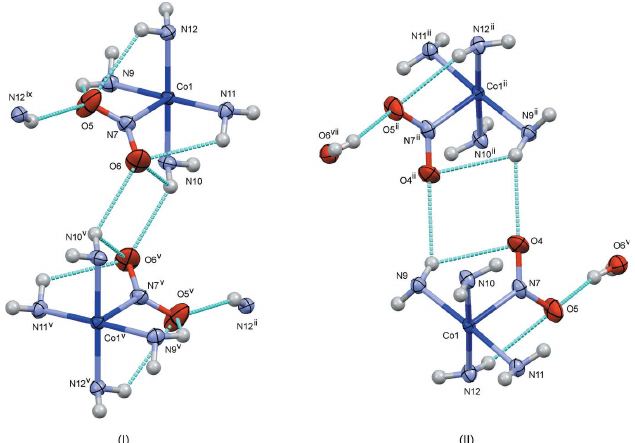
Figure 11 Comparison of the short contact pair of the nitro group in (I) and (II). Dashed lines in blue show the O(nitro) (cid:2)(cid:2)(cid:2) H short contacts shorter than 2.5 A˚ . Only parts of the diamine ligands are shown for clarity. Symmetry codes for (I): (ii) (cid:3) x + 1 , y (cid:3) 1 , (cid:3) z + 1 ; (v) (cid:3) x + 1 , (cid:3) y + 1 , (cid:3) z ; (ix) x , (cid:3) y , 2 2 2 2 2 z (cid:3) 1 , . For (II): (ii) (cid:3) x + 1, (cid:3) y + 1, (cid:3) z + 1, (v) x (cid:3) 1 , (cid:3) y + 3 , z + 1 ; (vii) 2 2 2 2 2 (cid:3) x + 1 , y + 1 , (cid:3) z + 3 . 2 2 2